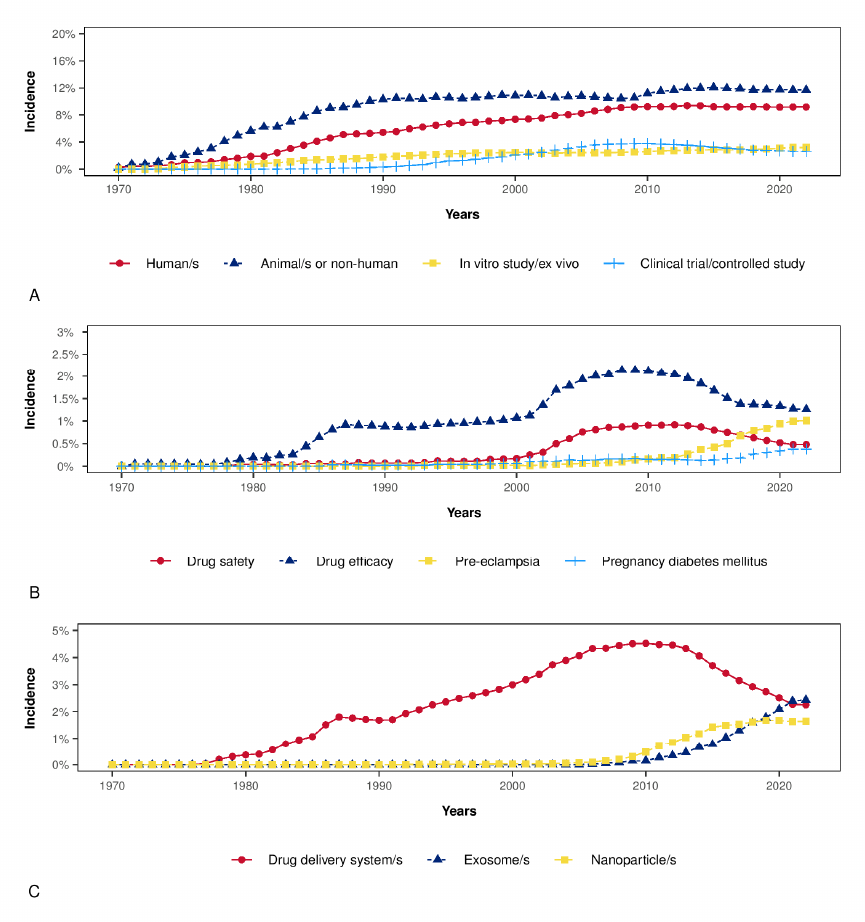
Figure 2. These plots show the annual incidence of a selected group of keywords among the top